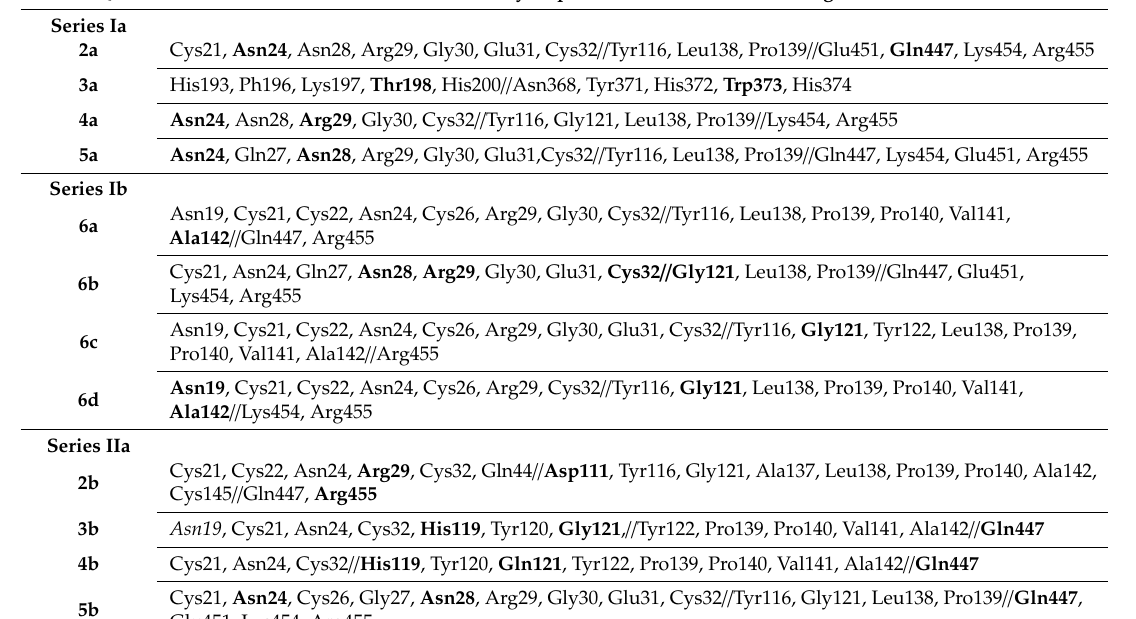
Table 2. Binding site contacts of BIZQs with partial amino acids sequences of COX-2. BIZQ H-Bonds and Hydrophobic Contacts in the Binding Site